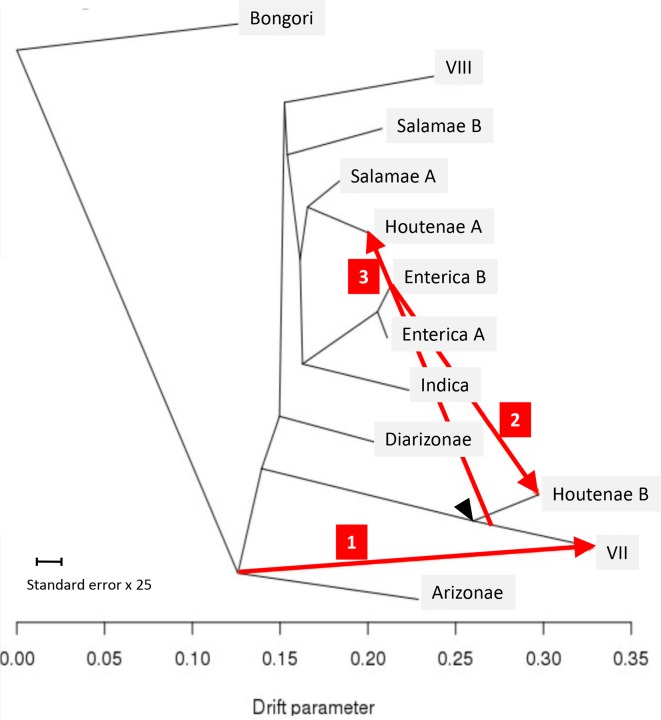
Treemix analysis of 12 genomes representative of phylogroup diversity. The black arrowhead indicates the position of the ancestor contributing to extant Houtenae A, Houtenae B and VII lineages. The red arrows indicate gene fluxes inferred by Treemix from one position on the tree to another.